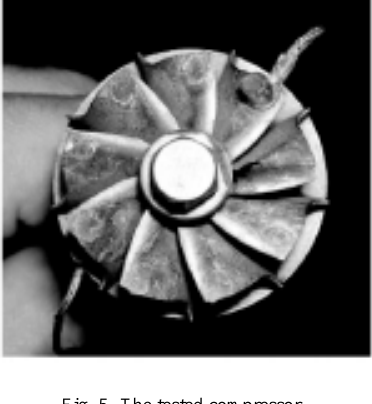
Fig. 5. The tested